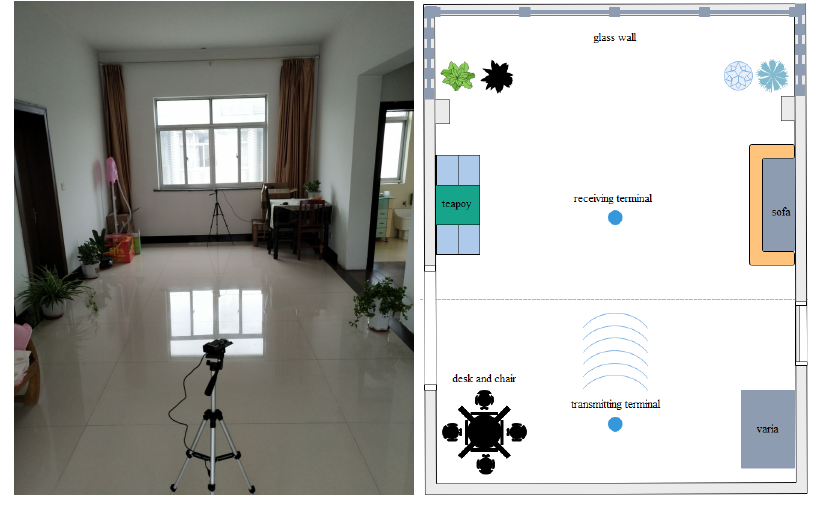
Fig. 1 Experiment